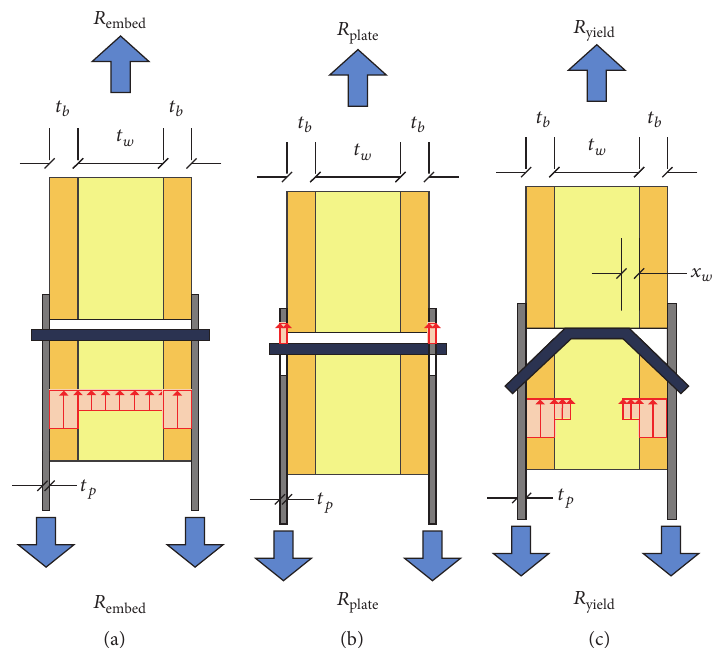
Figure 15: Possible failure modes (a)–(c) for double exterior connection plates corresponding to the tests discussed in Section 4.7: (a) embedment failure in the PlyBoard panel; (b) embedment failure in the steel plates; and (c) yielding of screw.